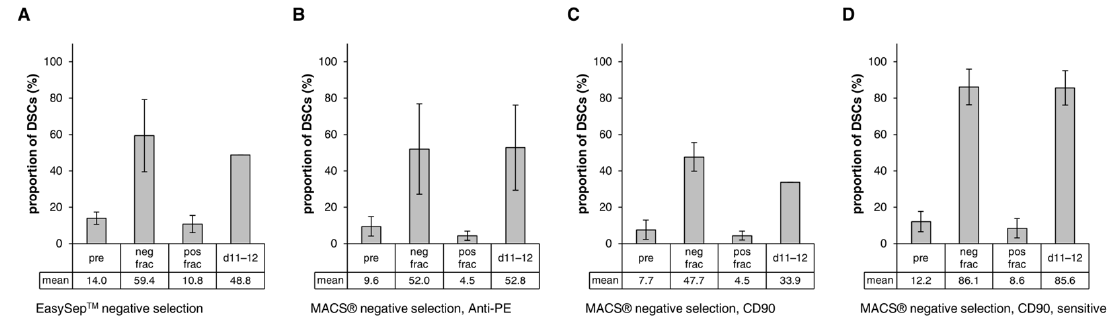
Figure 4. Negative selection (labeling of fibroblasts). ( A ) EasySep™ column ‐ free negative selection with the EasySep™ Human PE Positive Selection Kit II in combination with a PE ‐ conjugated anti ‐ CD90 antibody (StemCell Technologies). Sample size: n = 5. ( B ) MACS ® automatic column ‐ based